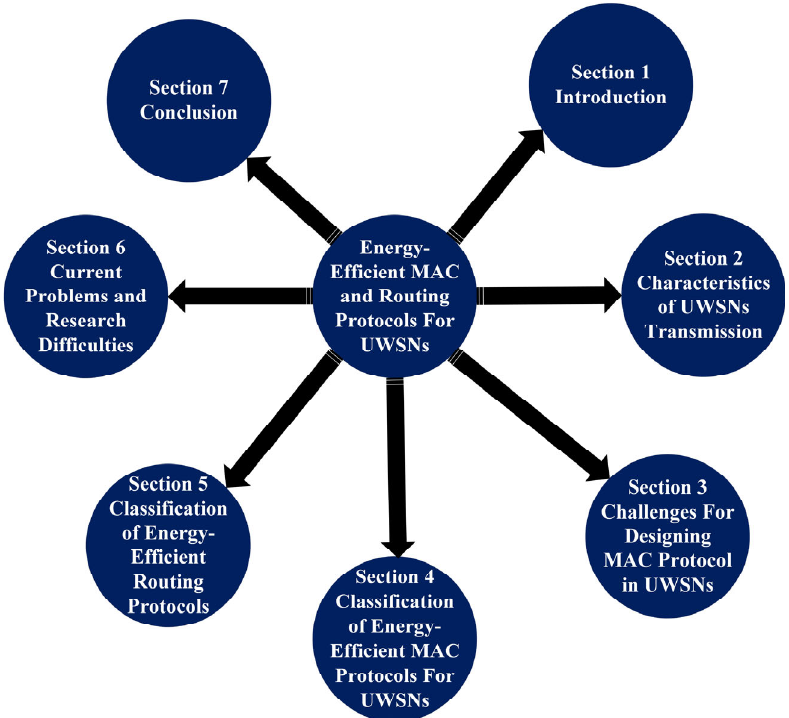
Figure 1. An overview of the paper.